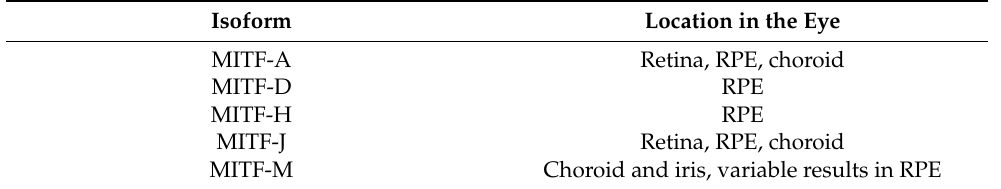
Choroid and iris, variable results in